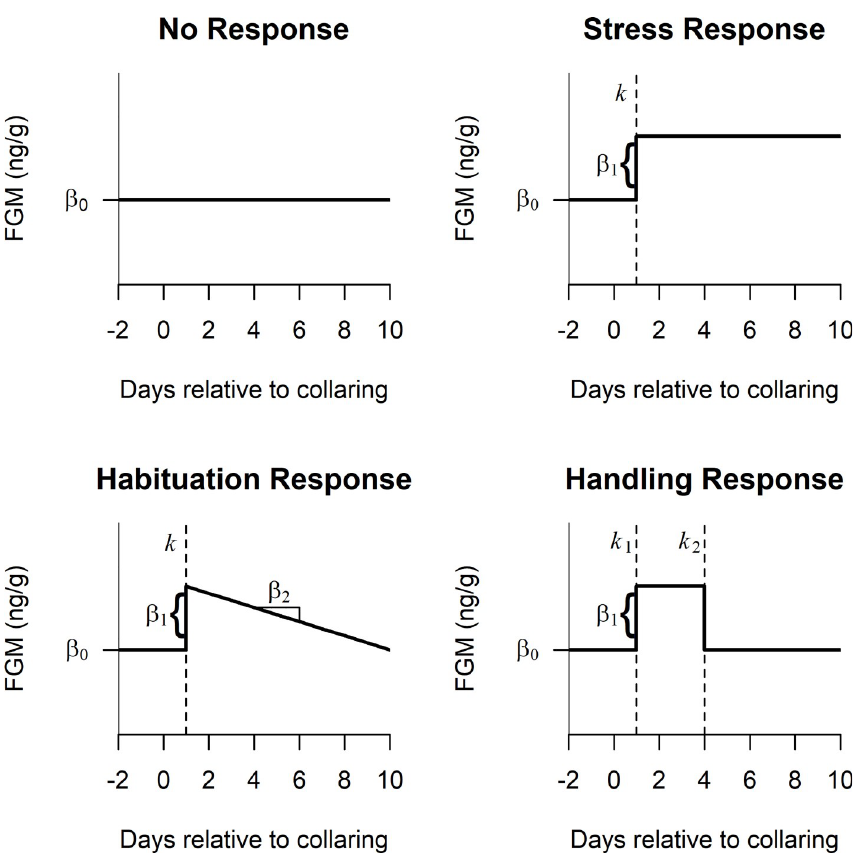
Fig 1. Hypothesized fecal glucocorticoid metabolite (FGM) (ng/g) adrenal responses to GPS collaring fitting [Day 0 = collar fitting date]. No Response—consistent linear trend with no slope; “Stress” Response—increase in FGM that does not subside; Habituation Response—increase in FGM that declines slowly over time; Handling Response— increase in FGM that declines rapidly. FGM response is time lagged [Day 1, dashed vertical line (k or k1, model dependent)] due to the time in which hormones enter the circulatory system and are metabolized (i.e., the gut passage time; [28–30]).